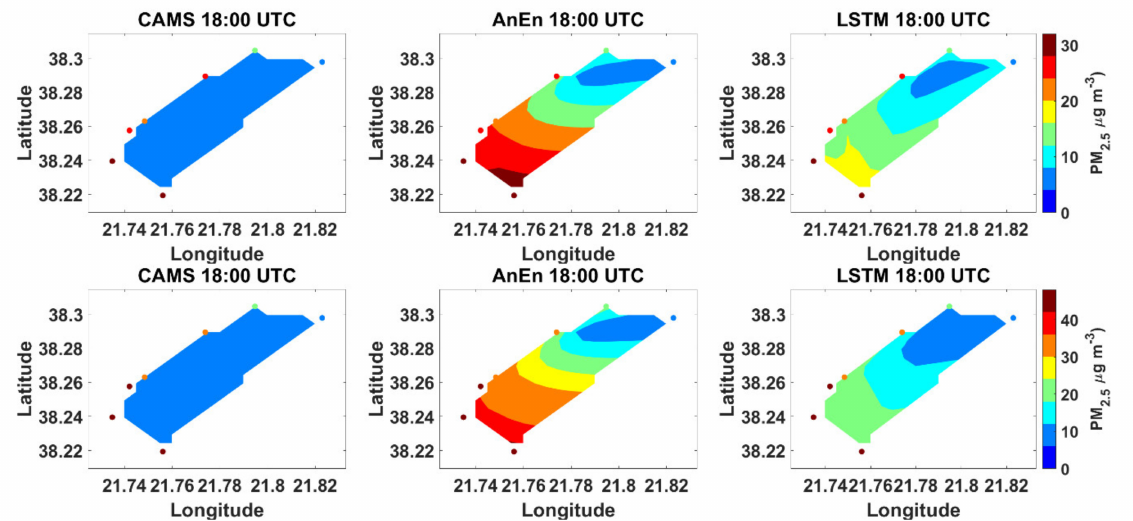
Figure 12. Forecast maps of PM 2.5 ( top row ) and PM 10 ( bottom row ) from CAMS ( left column ), AnEn ( middle column ) and LSTM ( right column ). Measurements have been superimposed as colored points at all charts. For AnEn and LSTM, the maps were generated from triangulation-based natural neighbor